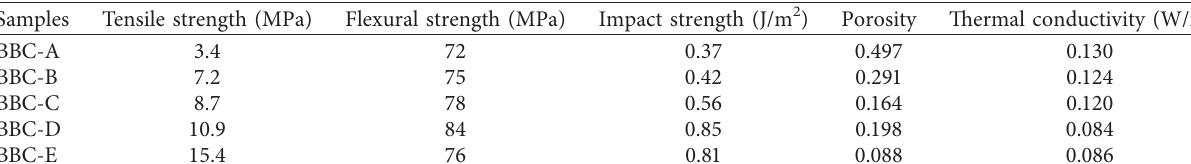
Figure 5: Tensile test SEM images of sample A (a), sample B (b), and sample C (c). Table 2: Physical and mechanical properties of sample composite materials.